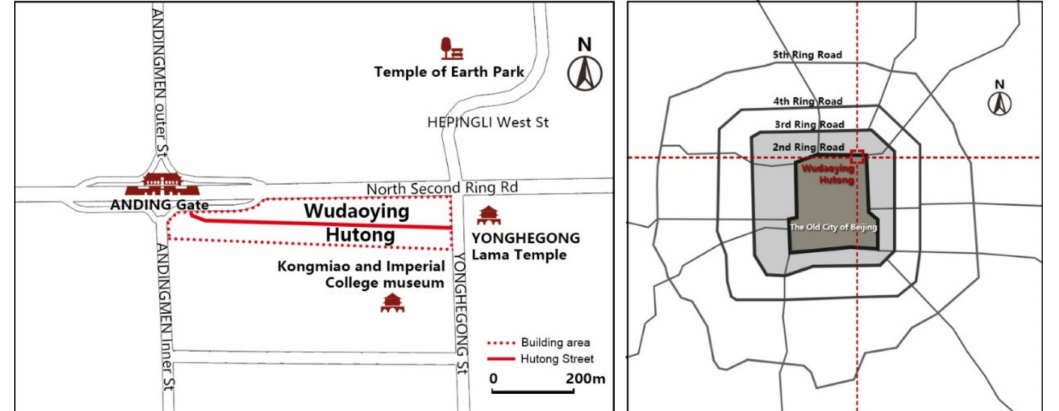
Figure 1. Location of Wudaoying